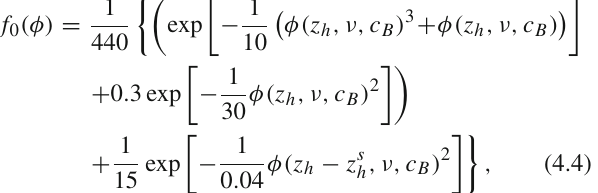
dot-dashed line presents the Hawking–Page phase transition points. Dashed lines represent values of σ 11 calculated in thermodynamically unstable